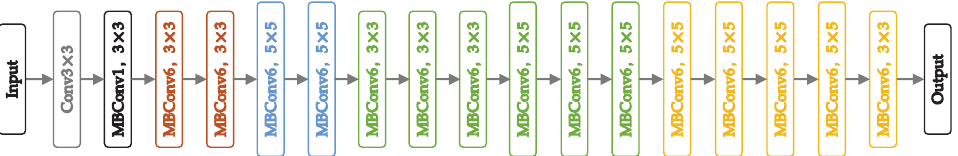
Figure 2. EfficientNet is composed of 16 large Blocks stacked, 16 large Blocks can be divided into 1, 2, 2, 3, 3, 4, 1 Blocks. 3 × 3/5 × 5 represent the convolutional kernel size respectively. The different Blocks are distinguished by color and convolutional kernel size.